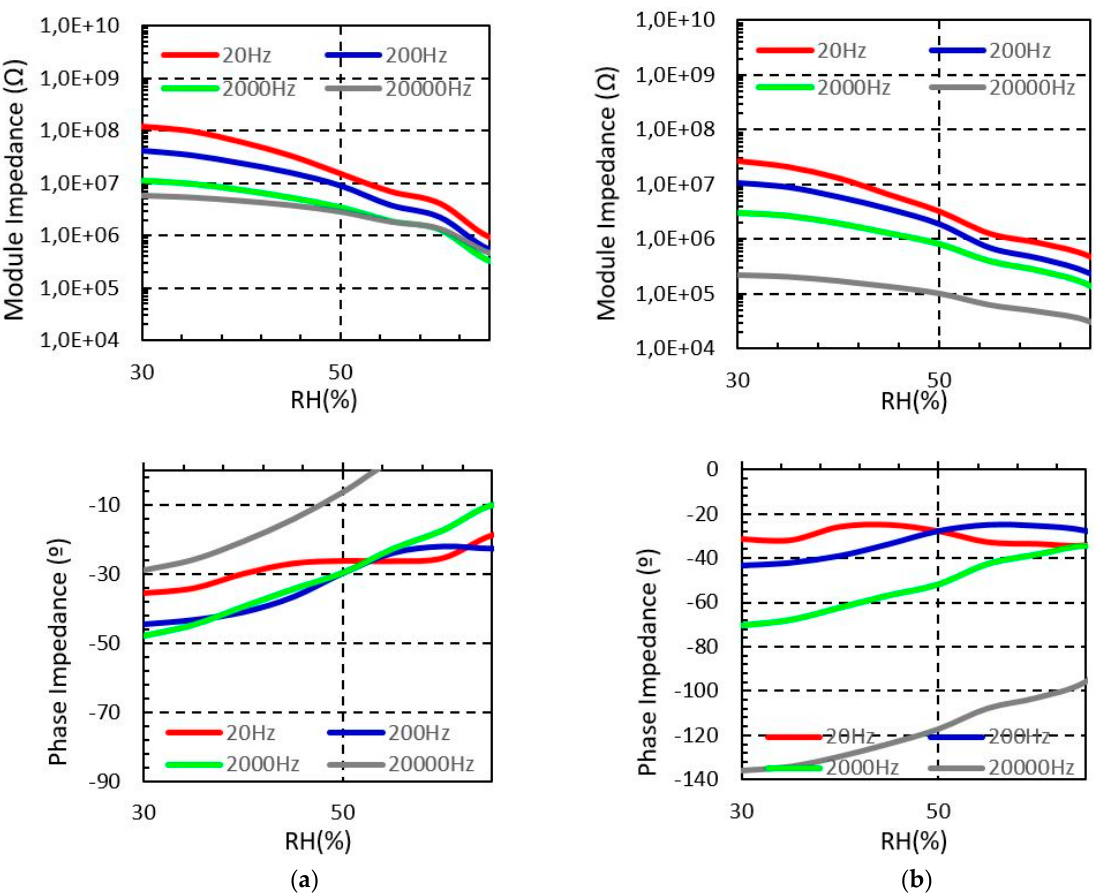
Figure 5. Measured Bekaert (PES-SS) sensors impedance from 30% to 65% RH at different frequencies (T = 20°C). ( a ) Short sensor impedance ( b ) Long sensor impedance.